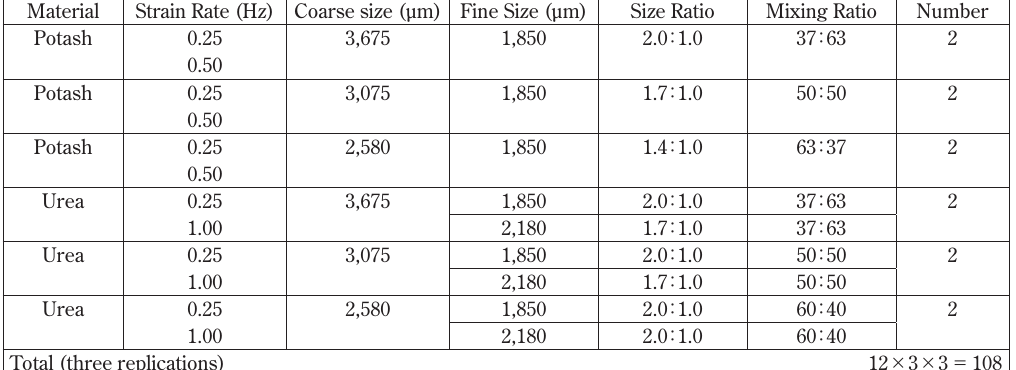
Table 3 Validation design for binary size mixtures for potash and urea *